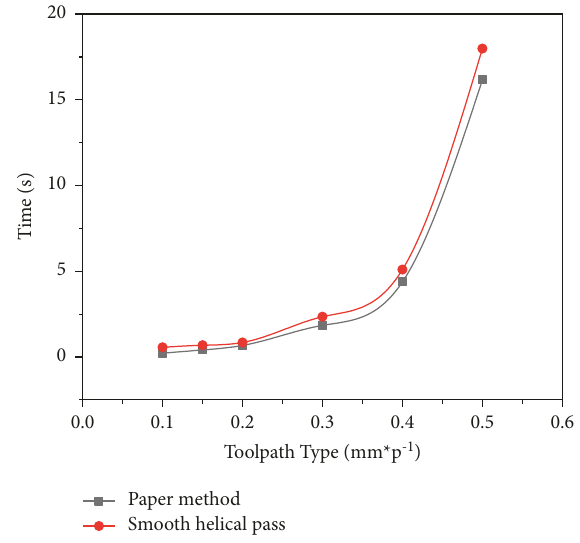
Figure 5: Comparison of processing path calculation efficiency (smooth helical Table 1: The relationship between calculation efficiency and tool diameter change.